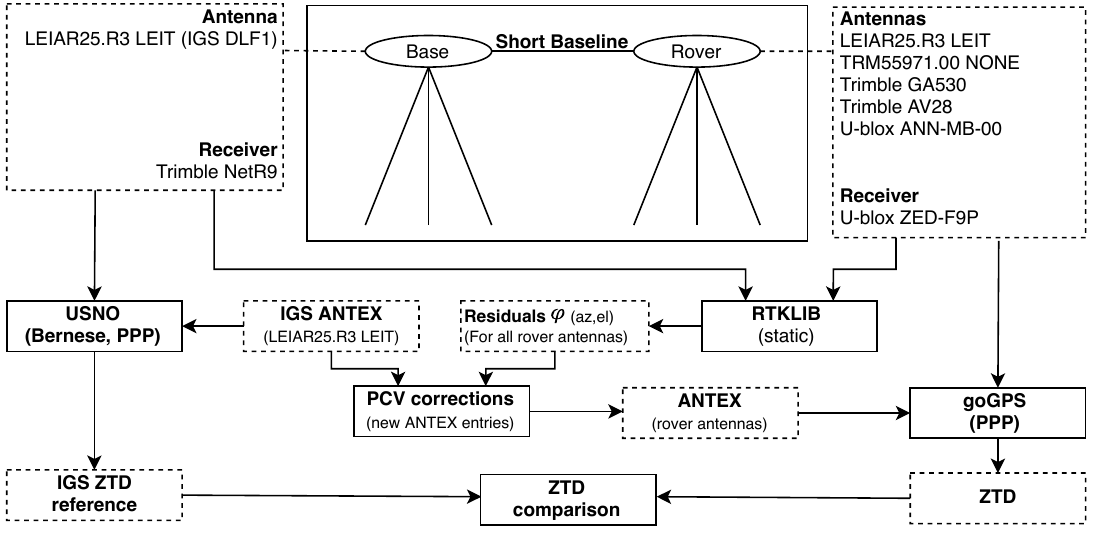
Figure 2. Steps in the Zenith Tropospheric Delay (ZTD) evaluation procedure. The top central box illustrates the short baseline with base station (DLF1) on the left and rover on the right. The base station DLF1 uses a Trimble NetR9 receiver and LEIAR25.R3 LEIT antenna, which did not change during the time frame of our experiment. The rover is illustrated on the right, with an U-blox ZED-F9P receiver and five antenna types applied